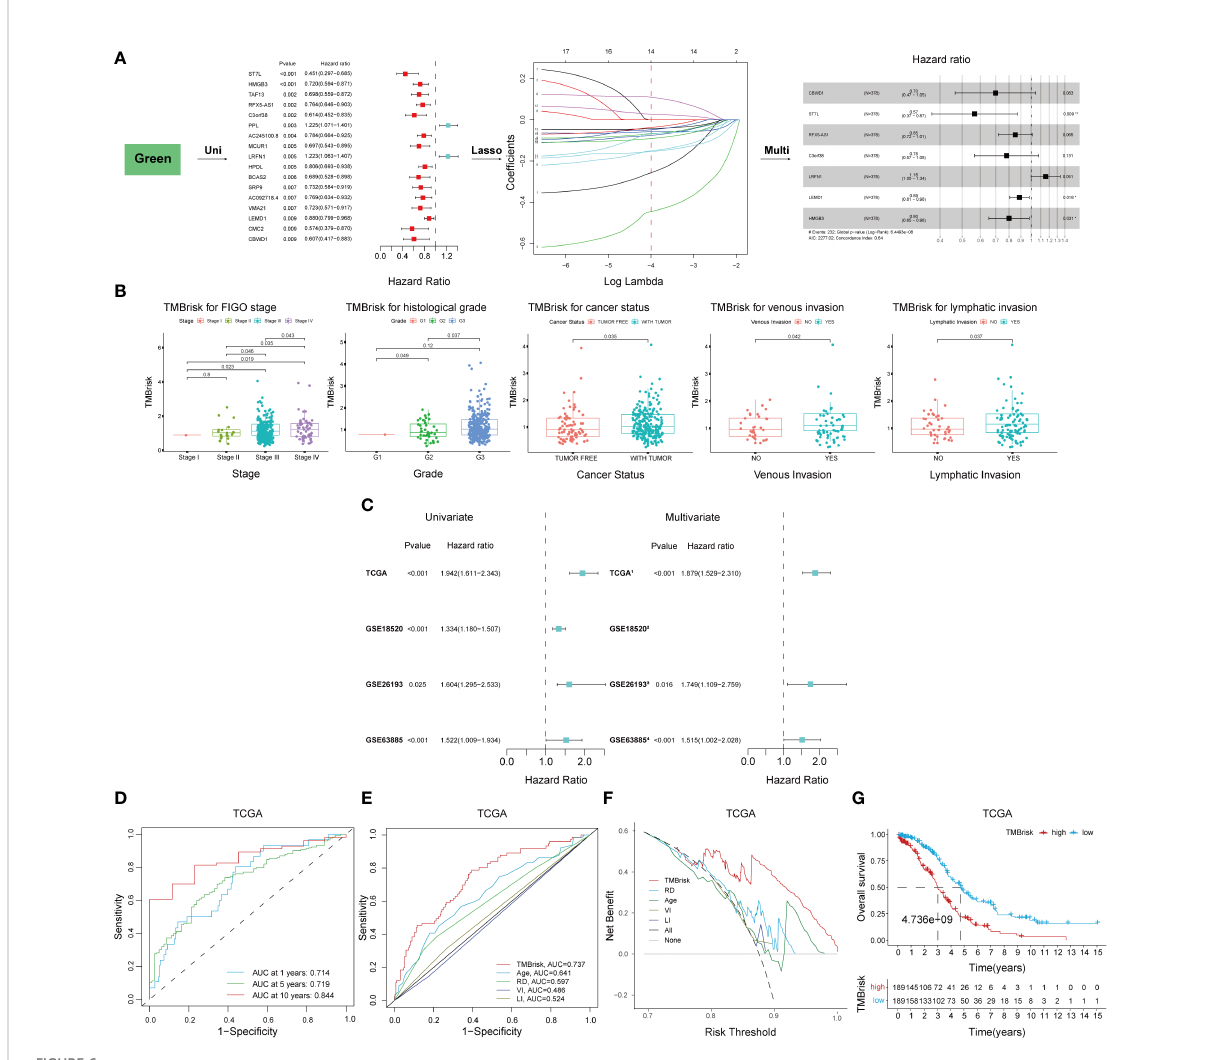
FIGURE 6 Establishment and validation of the TMBrisk model. (A) Cox regression analyses for selecting gene signatures. The fi rst forest plot showing genes with p < 0.01 in univariate Cox analysis. These genes were further inputted into LASSO analysis. The y-axis showed LASSO coef fi cients and the x-axis was – log (lambda). Dotted vertical lines represented 1 standard error values of lambda. The genes selected at 1 standard error values of lambda were fi nally used for multivariate Cox analysis, with the second forest plot showing the best signature. (B) Difference analysis of the distribution of TMBrisk in different clinical characteristics. (C) Forest plot of Cox analysis in TCGA and GEO datasets. (1) For multivariate Cox regression analysis, HR value of TMBrisk was adjusted by age, FIGO stage, histological grade, residual disease, cancer status, venous invasion, and lymphatic invasion. (2) The multivariate analysis was not performed in GSE18520 because of missing clinical information. (3) For multivariate Cox regression analysis, HR value of TMBrisk was adjusted by FIGO stage and histological grade. (4) For multivariate Cox regression analysis, HR value of TMBrisk was adjusted by residual tumor size, FIGO stage, and histological grade. (D) ROC curves of TMBrisk for 1-, 5-, and 10-year survival prediction in TCGA. (E) ROC curves of TMBrisk and other prognostic predictors for 2-year survival prediction in TCGA. (F) DCA for TMBrisk and other prognostic predictors. The y-axis represented net bene fi t and the x-axis represented risk threshold. The black line represented the hypothesis that all patients had OC. The gray line represented the hypothesis that no patient had OC. (G) High-TMBrisk group correlated with poor survival outcome in TCGA, with p < 0.0001. TMB, tumor mutational burden; LASSO, Least Absolute Shrinkage and Selection Operator; FIGO, International Federation of Gynecology and Obstetrics; ROC, receiver operating characteristic curve; RD, residual disease; VI, venous invasion; LI, lymphatic invasion; DCA, decision curve analysis; HR, hazard ratio; 95% CI, 95% con fi dence